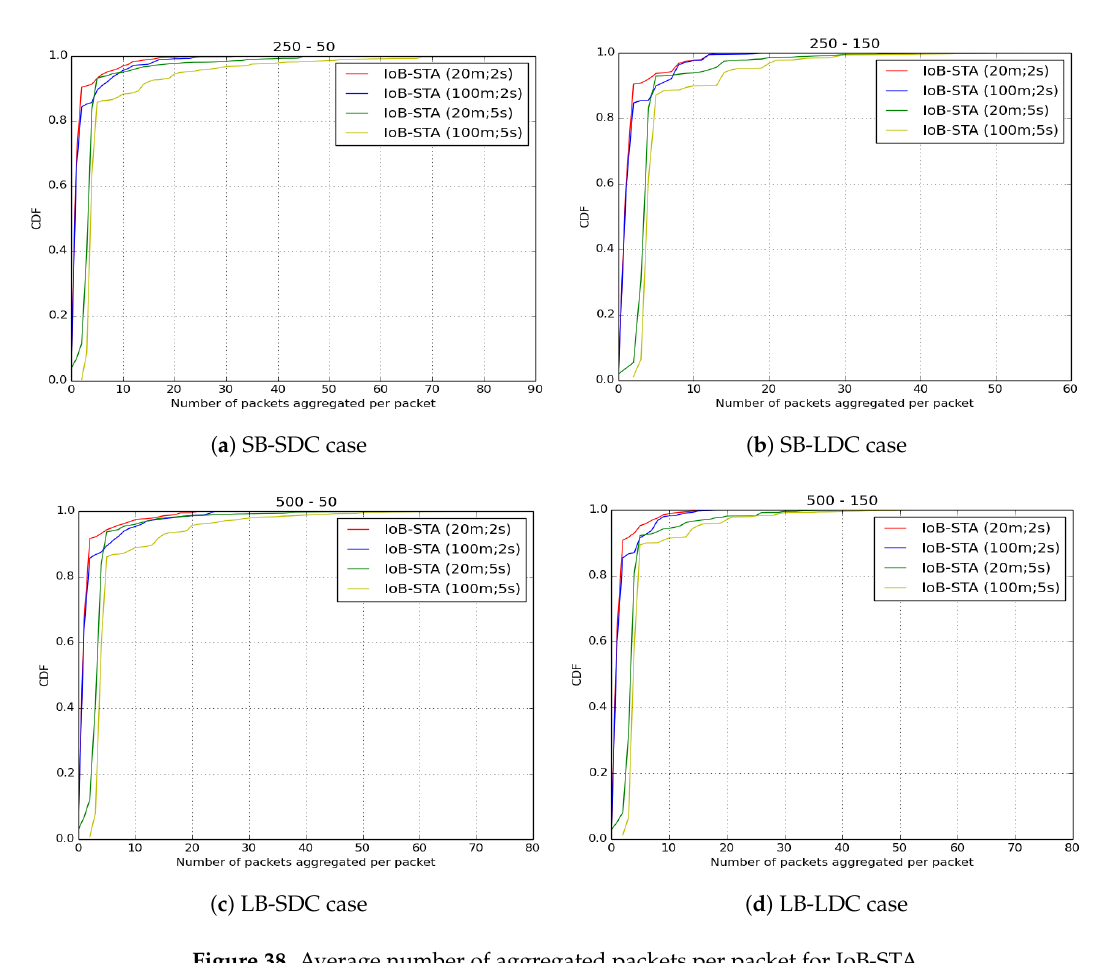
Figure 38. Average number of aggregated packets per packet for